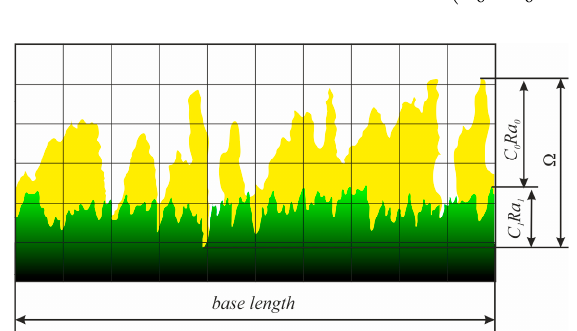
Figure 5. Scheme of surface roughness before and after grinding with a fine-grained wheel.